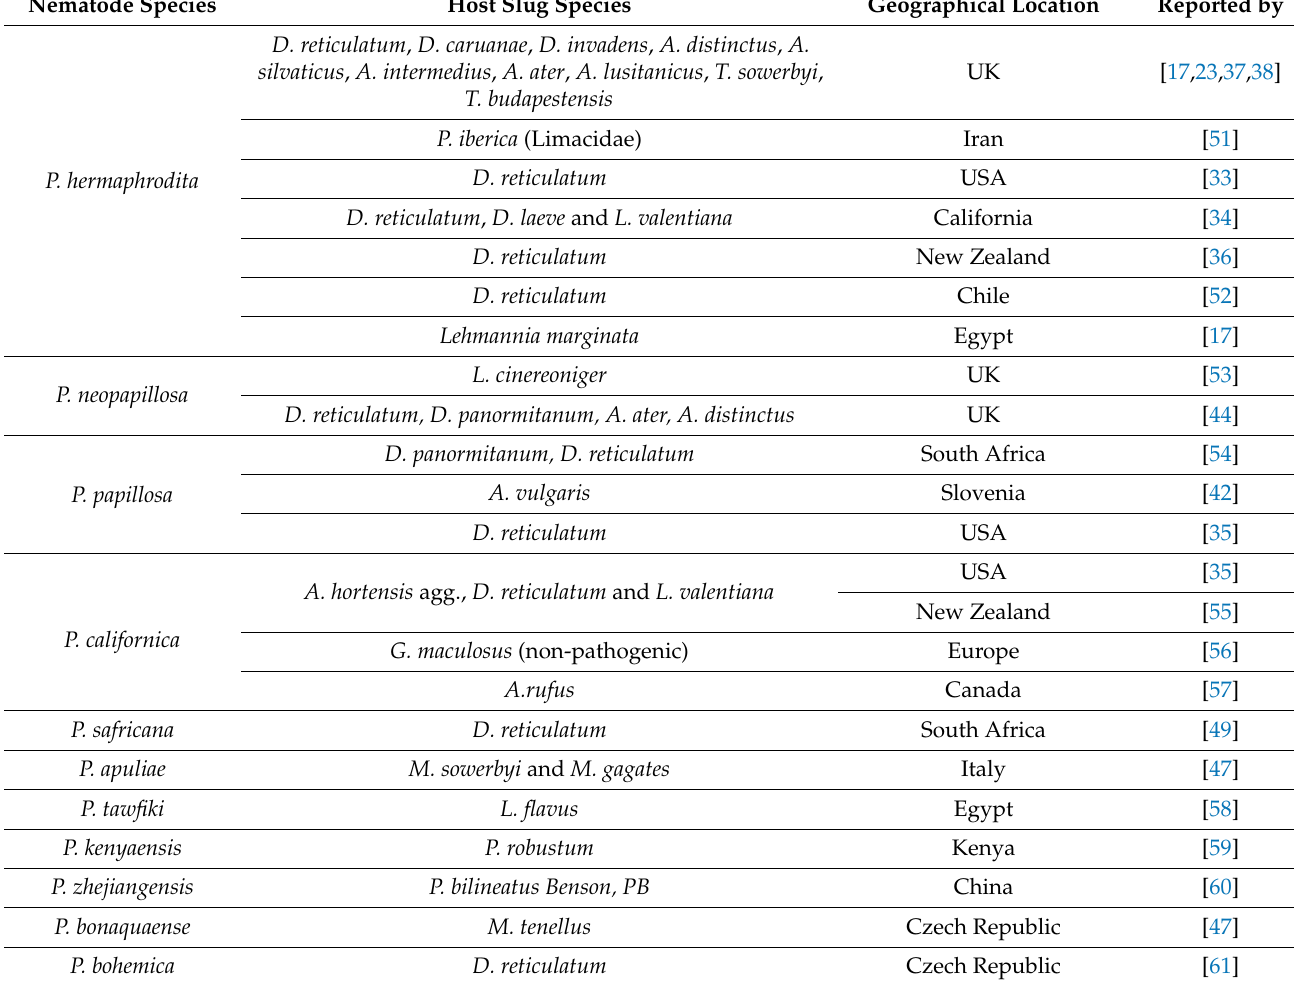
Table 1. List of Phasmarhabditids that associate with slugs. Host Slug Species Geographical